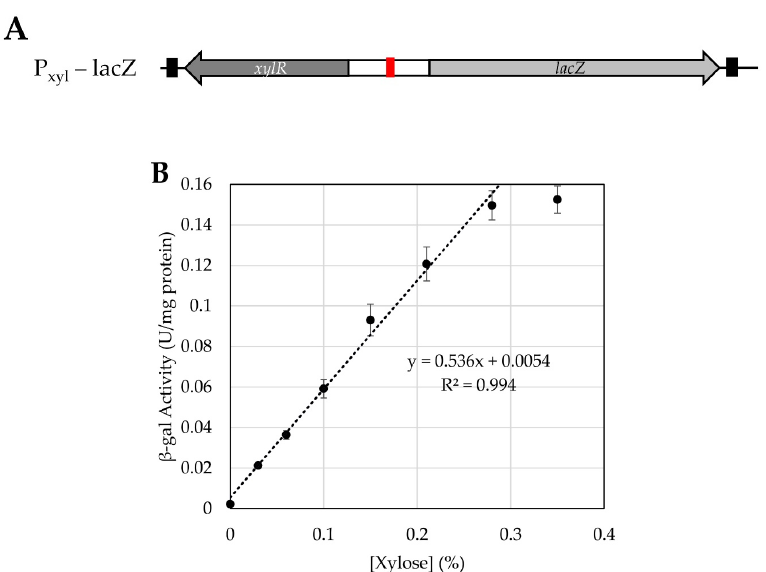
Figure 8. Xylose inducible promoter gene set-up ( A ) and promoter activity tuned by concentration of xylose present in media ( B ). In the schematic ( A ), the red box represents the operator, xylO , present in the promoter for the lacZ reporter. The xylR gene encoding the repressor is upstream and in the opposite orientation of this site; it is expressed constitutively. Terminators are present at either end of this sequence, represented as black boxes. In ( B ), specific activity is reported as β -gal units per mg protein versus xylose concentration ( w / v ). Each point represents the average of a biological and technical triplicate ( n = 9), and error is represented as standard error.